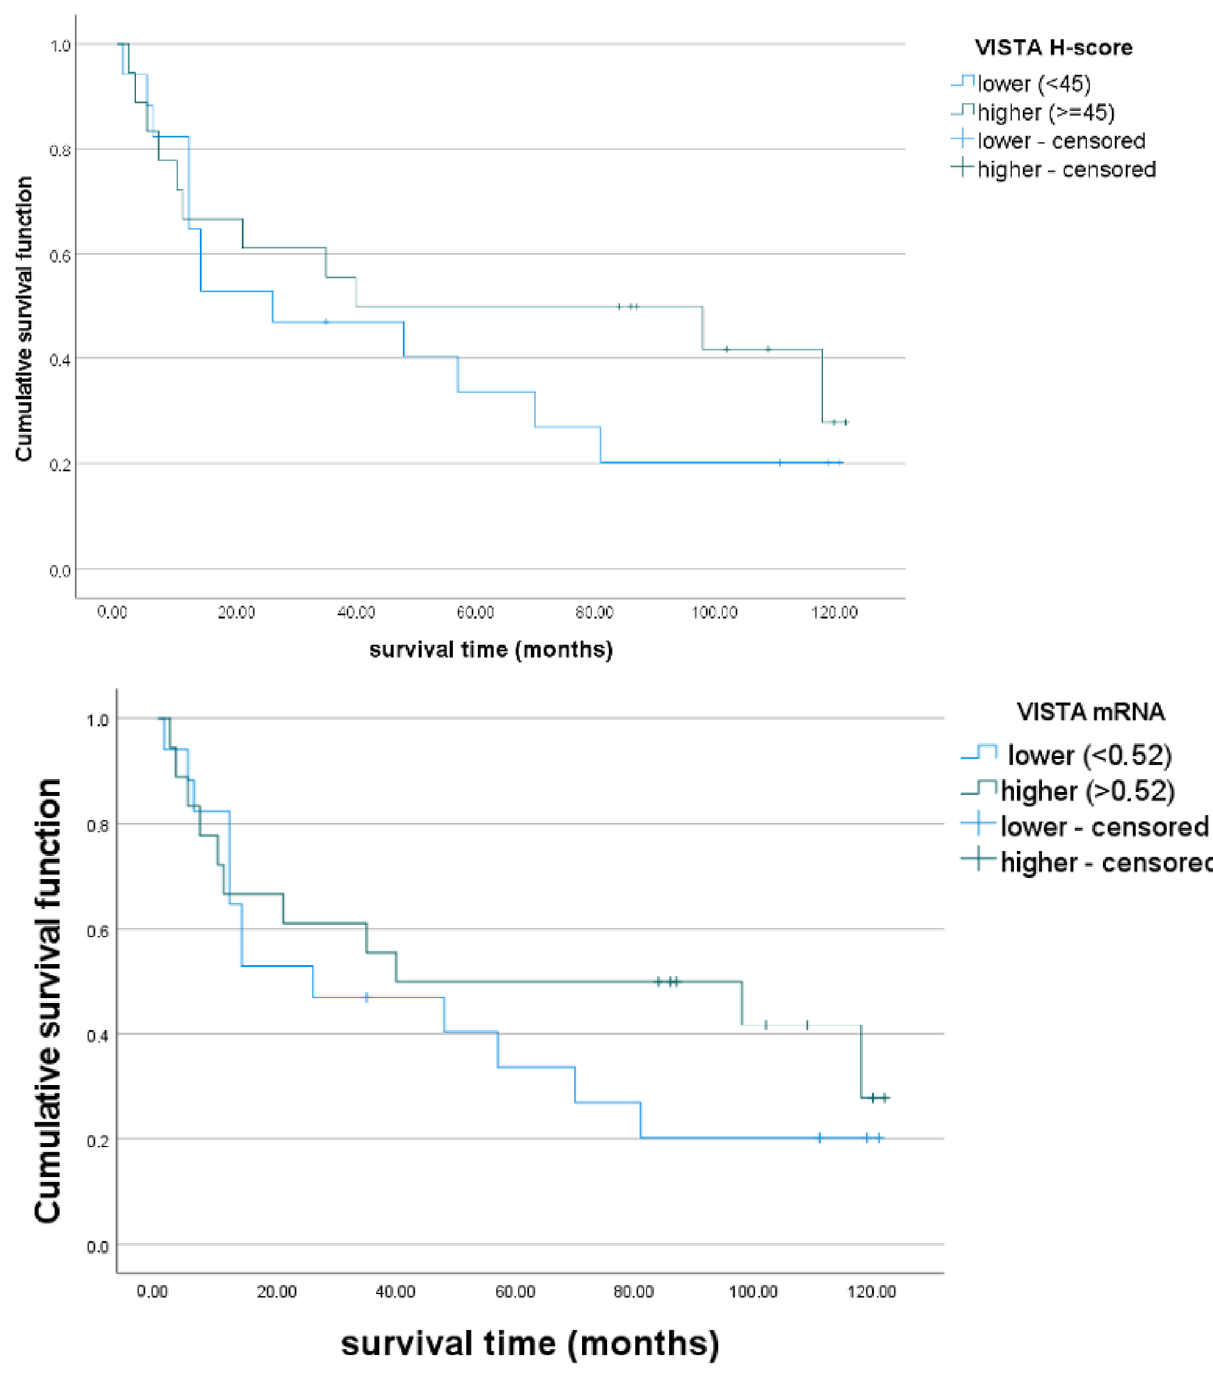
Figure 5. Overall survival in the two groups with higher and lower VISTA expression: Kaplan– Meier curves. Patients were divided according to the median of the H-score distribution into two groups with higher (H-score > 45, n = 33) and lower (H-score ≤ 45, n = 38) VISTA expression. The log-rank test showed no significant difference between groups. Regarding mRNA expression, we divided the cohort into two groups with higher (>0.52, n = 16) and lower mRNA (<0.52, n = 19) expression. Similarly, the difference between groups was non-significant in the log-rank test.